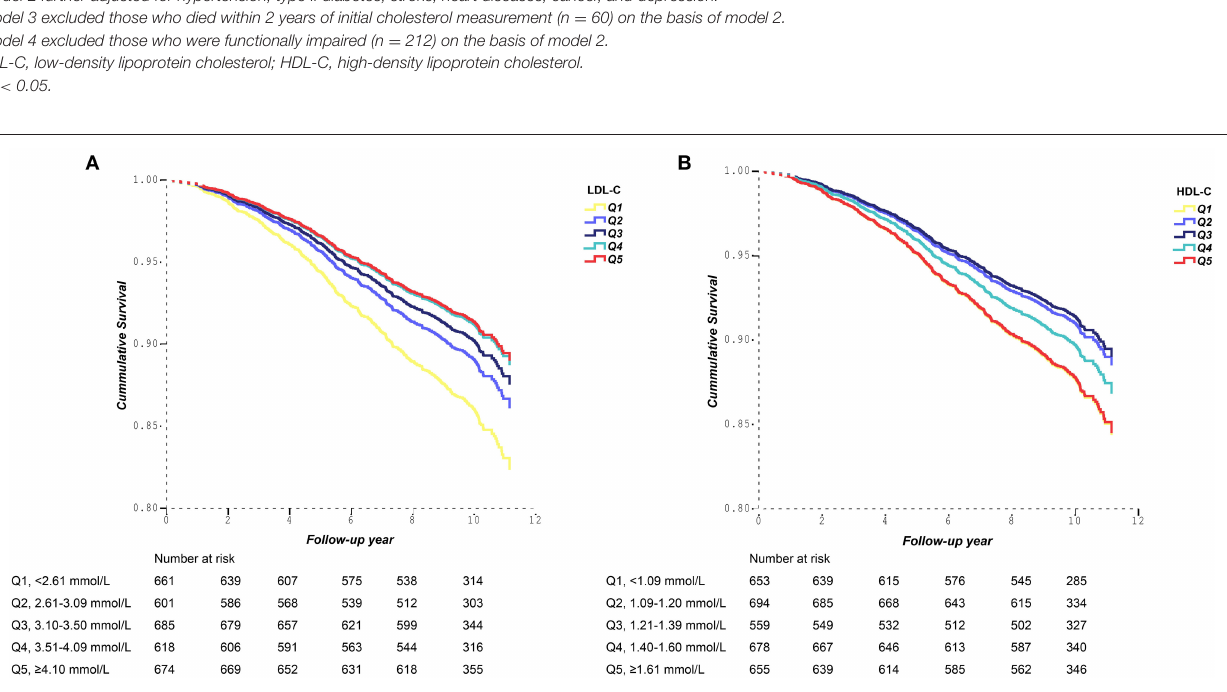
FIGURE 2 | Survival curves in subgroups according to quintiles of (A) LDL-C and (B)